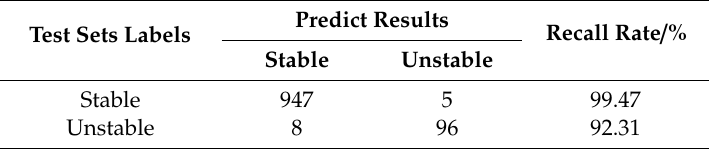
Table 4. Confusion Matrix for classification results of electromagnetic